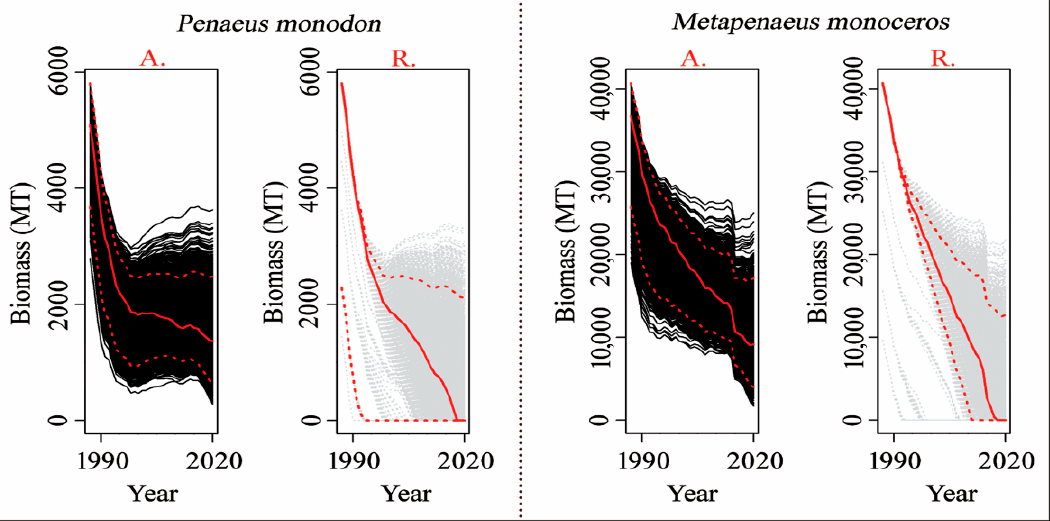
Figure 6. Biomass projections for Penaeus monodon and Metapeneaus monoceros from accepted (black) and rejected (white) model runs.